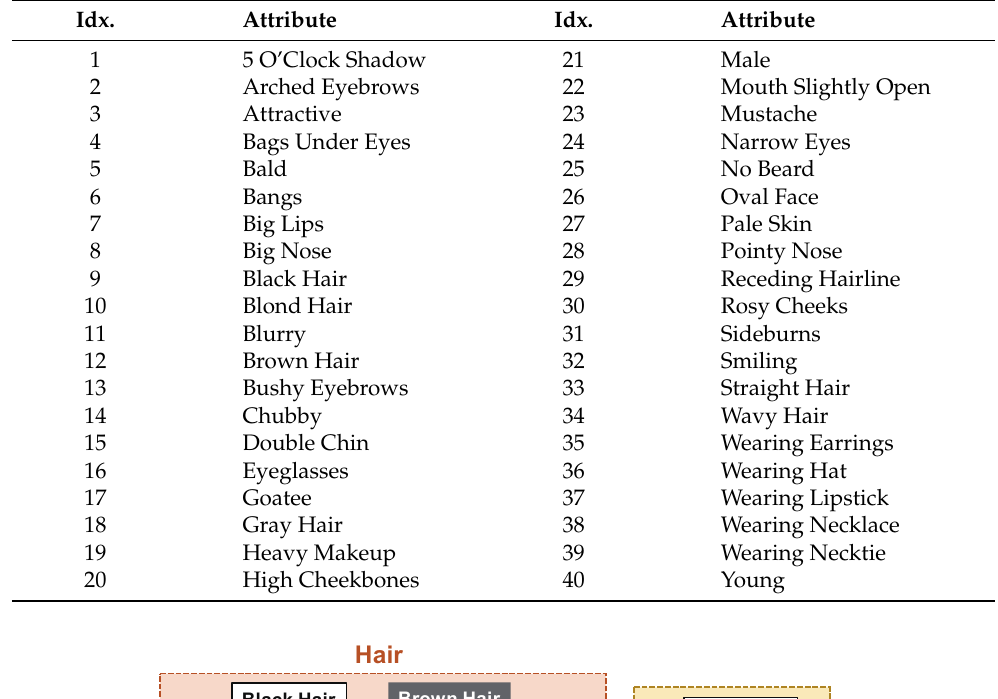
Table 2. Face attribute labels defined in CelebA [9].